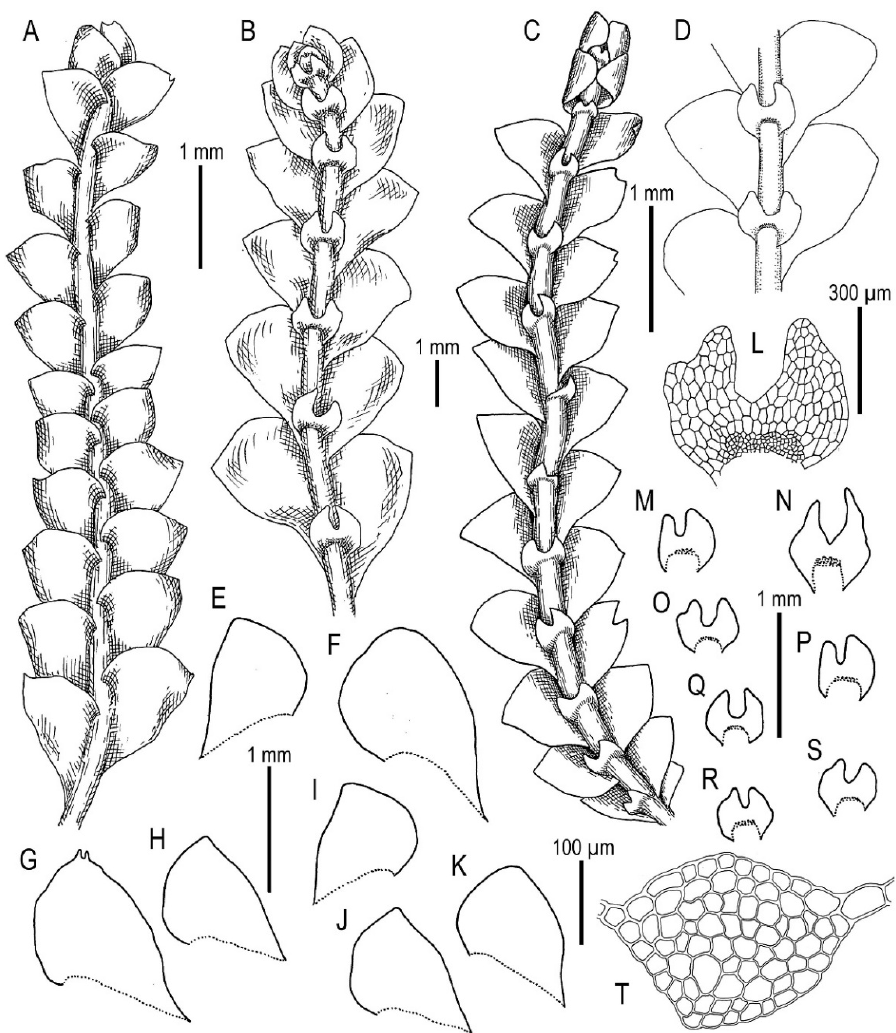
Figure 19. Calypogeia kamchatica Bakalin, Troizk. et Maltseva, sp. nov. : ( A ) Plant habit, fragment, dorsal view; ( B – D ) Plant habit, fragment, ventral view; ( E – K ) Leaves; ( L – S ) Underleaves; ( T ) Stem cross section. ( C ) From K-129-21-04 and ( A – T ) from K-63-1-15. All from VBGI.